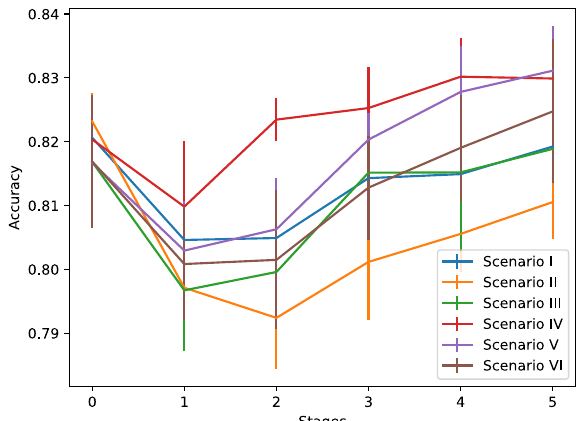
Figure 6. Performance of the classifiers along the five learning stages for the six scenarios.